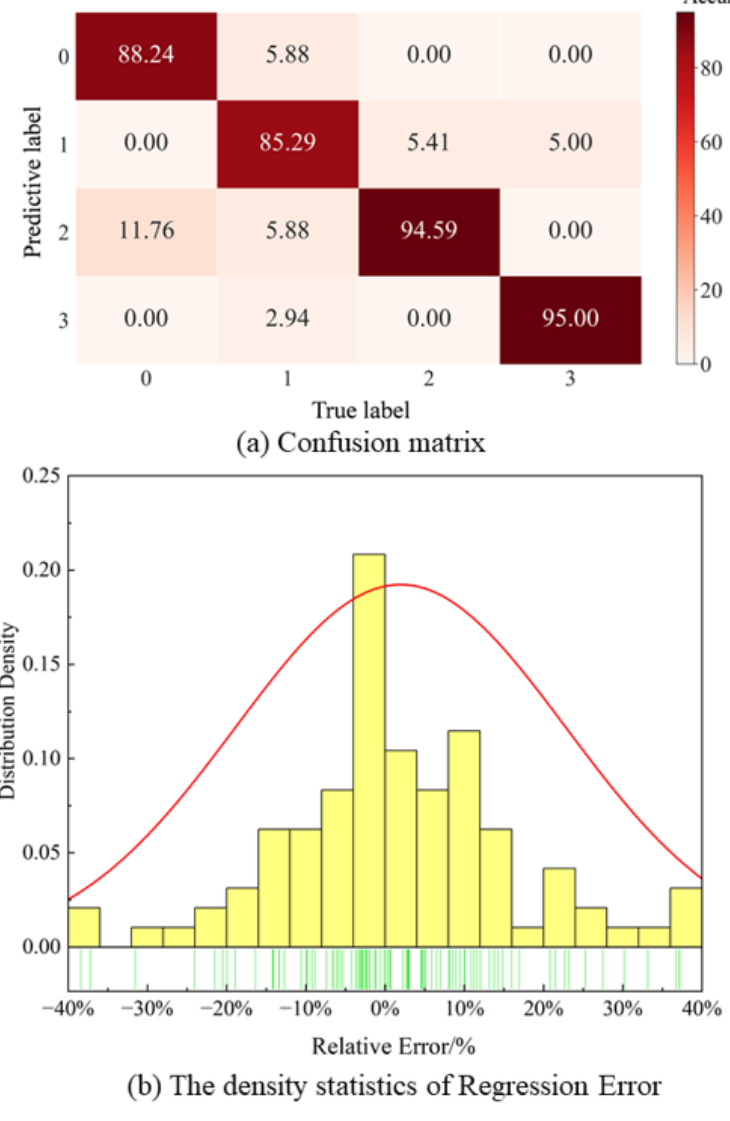
Figure 15. Detection results of crack location and depth of 1500 rpm blade.